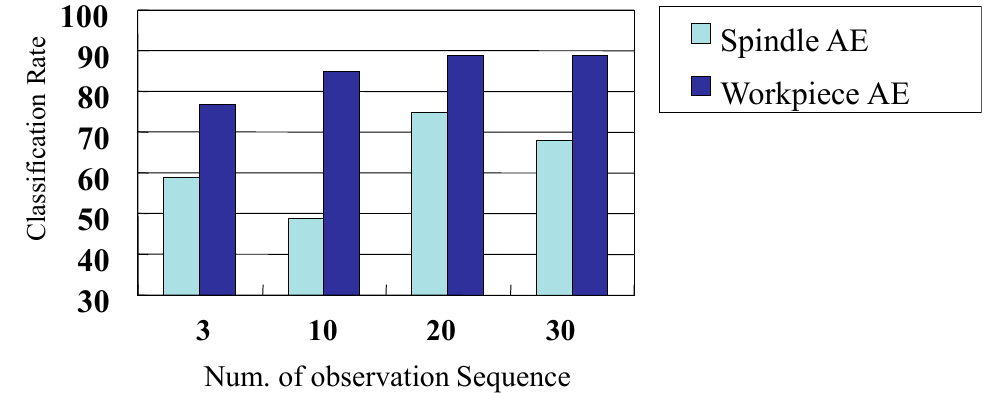
Figure 15. Effect of observation sequence on classification rate (16 kHz feature bandwidth).